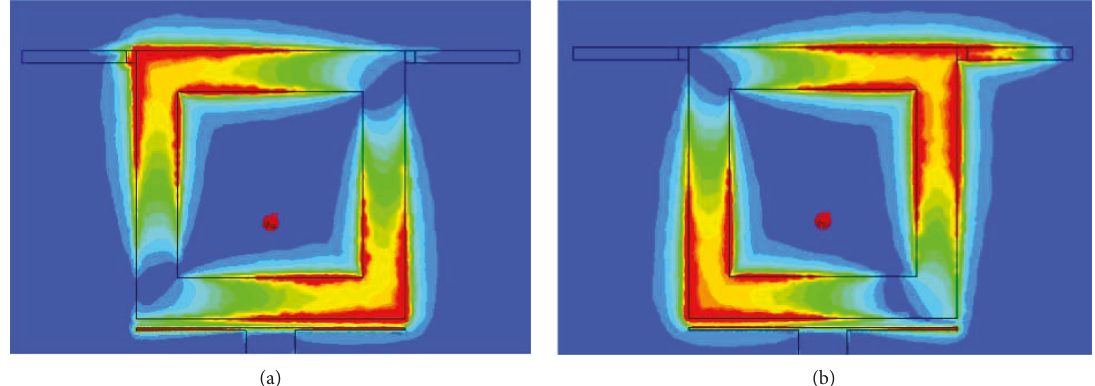
Figure 4: Simulated E- fi eld distribution of antenna 1: (a) f